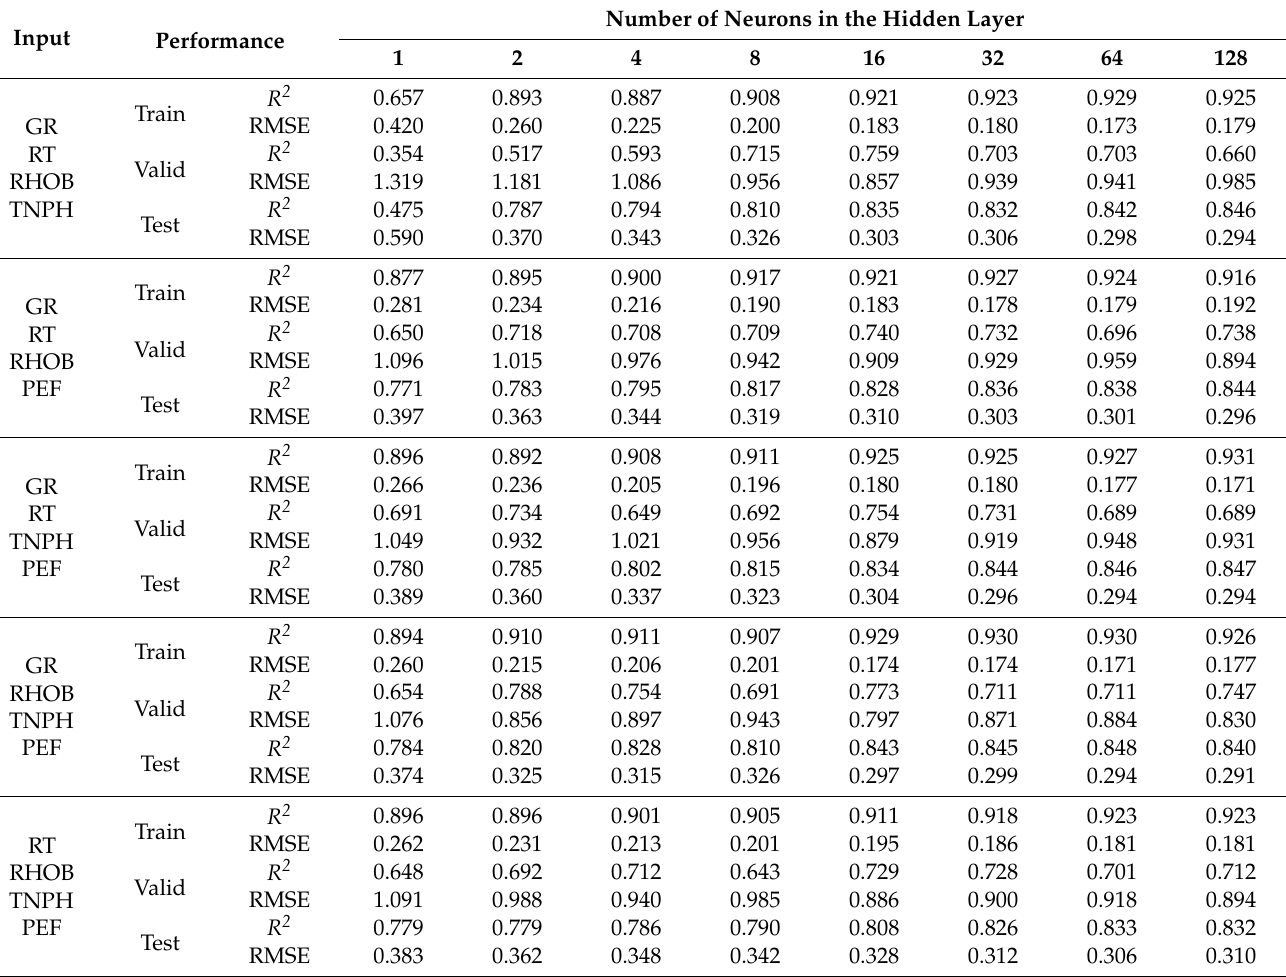
Table A4. Performance for generating synthetic Vp using four input